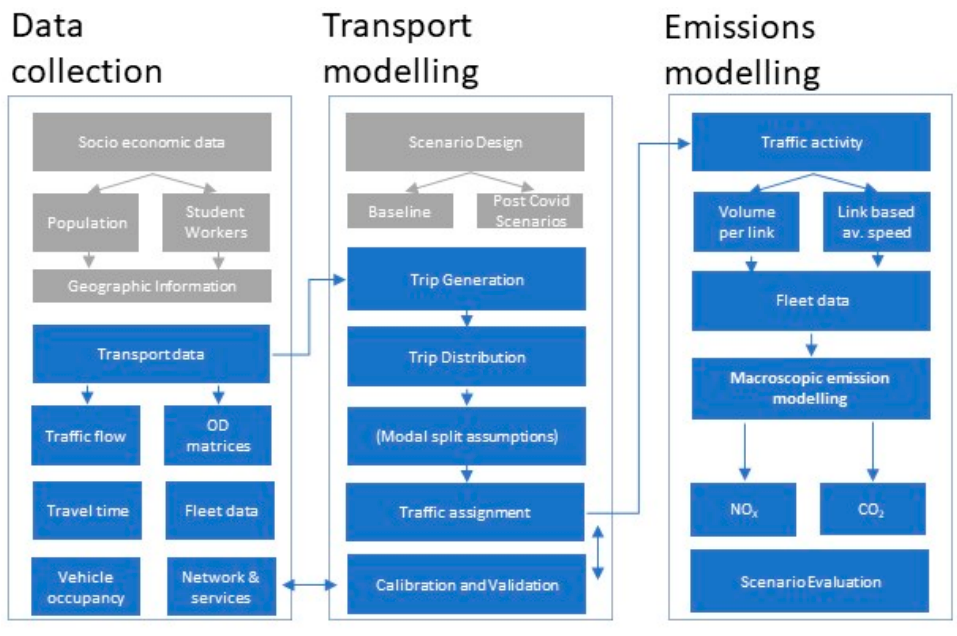
Figure 1. Methodology overview.